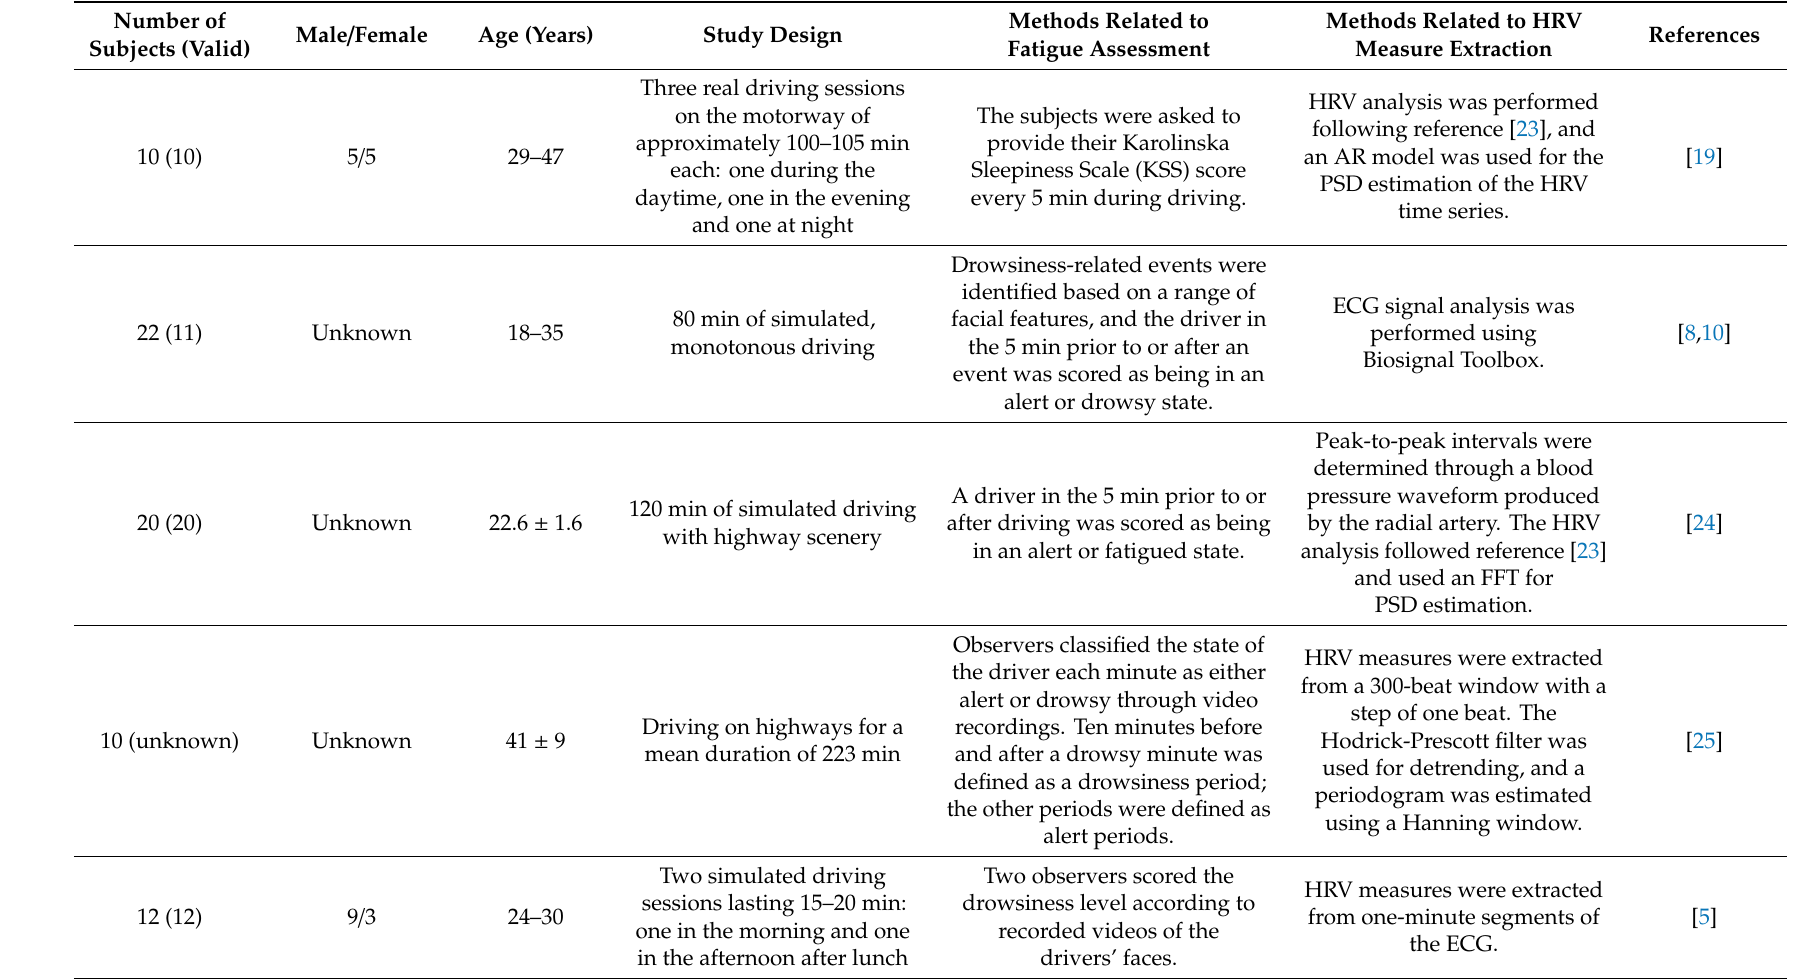
Table 1. Summary of studies related to HRV measures and driving